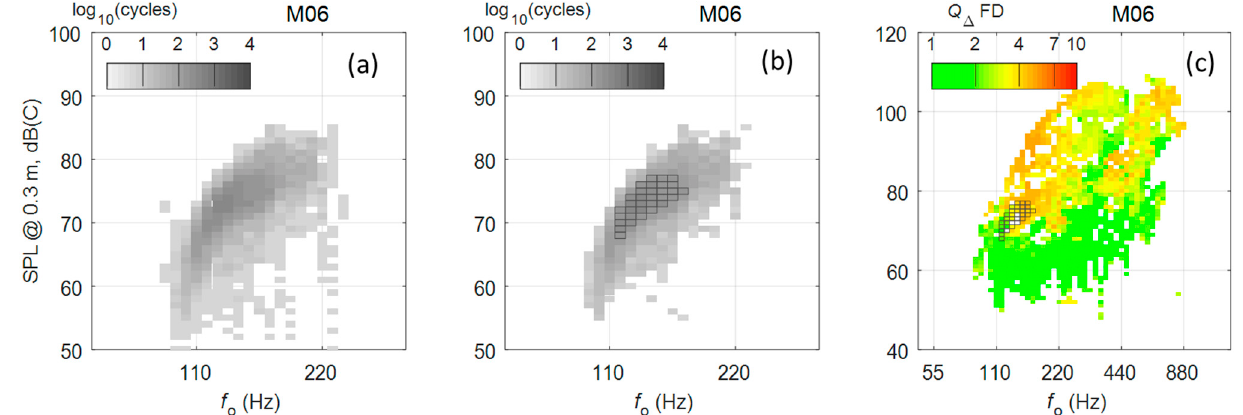
Figure 7. Finding the “most habitual” speech: a vocally healthy adult male read the Rainbow Passage 3 times, in a quiet environment. Panels ( a , b ) show the number of cycles phonated in each cell, on a log gray scale. This is the SRP, in the form of a 2D histogram. In ( b ), a 5-cycle minimum threshold per cell has been imposed, to suppress outliers. The black grid in ( b ) marks the Γ (gamma) region that delimits the central quartiles, that is, the most populated cells that contain 50% of the total cycle count. Panel ( c ) shows a voice map of the same person’s full voice range on the vowel /a:/ (note the change of scale), with Γ overlaid, and colour representing the metric Q Δ (normalized peak dEGG). Here, the full green colour represents absence or near-absence of vocal fold contacting. We note in passing how Γ , the “core” of the habitual speech, lies just above the green area. Presentation adapted from [18] (Supplement 1).